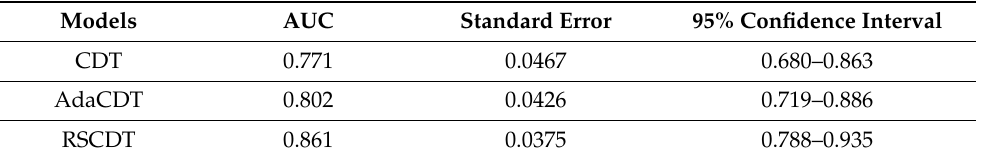
Table 6. ROC analysis of CDT, AdaCDT, and RSCDT models using validation data. Models